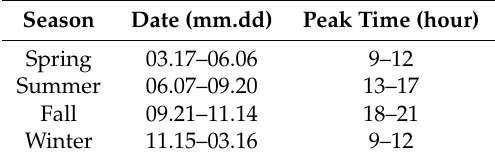
Table 1. Seasonal maximum load time for energy storage system (ESS)